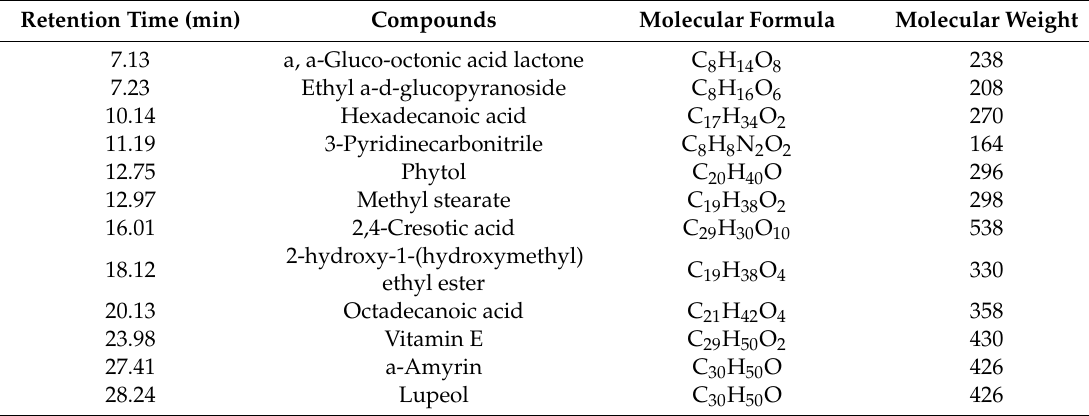
Table 1. Chemical composition of Ricinus communis leaf extract (RcExt) using GC-MS / MS. Retention Time